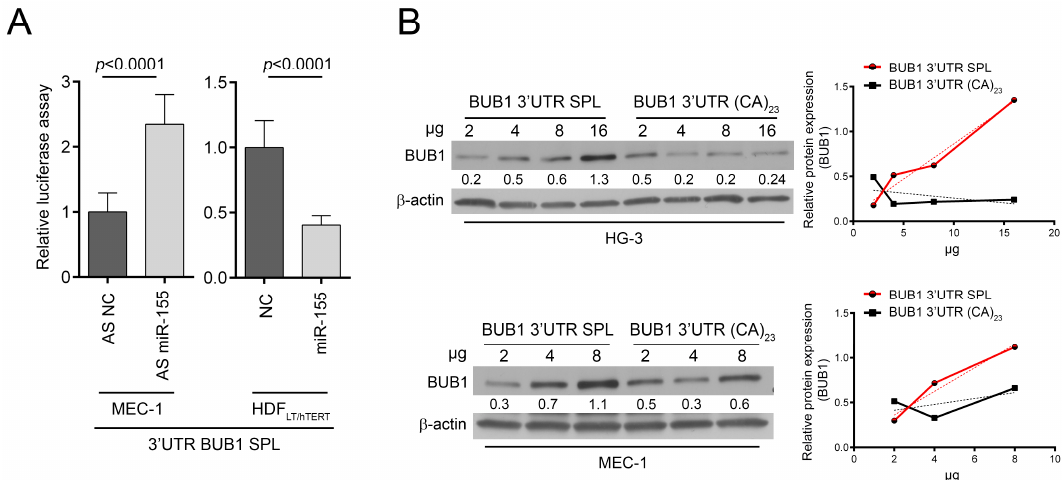
Figure 6. miR-155 targeting of BUB1 3 ′ UTR spliced form. ( A ) Relative luciferase activity in HG-3 and HDF LT/hTERT cells after transfection with miR-155 precursor (miR-155), antisense inhibitor oligonucleotide (AS miR-155), or respective negative controls (NC, negative control; and AS NC, anti-sense negative control) as indicated. Values are means ± SD of three technical replicates of two independent experiments. ( B ) Western blots of BUB1 in HG-3 and MEC-1 cell lines transfected with increasing doses of luciferase vectors carrying the spliced form (SPL) or the full BUB1 3 ′ UTR (23CA). Densitometric values, normalized to β -actin expression, are showed by line charts (SPL, red line; 23CA, black line; linear regressions, dotted lines).